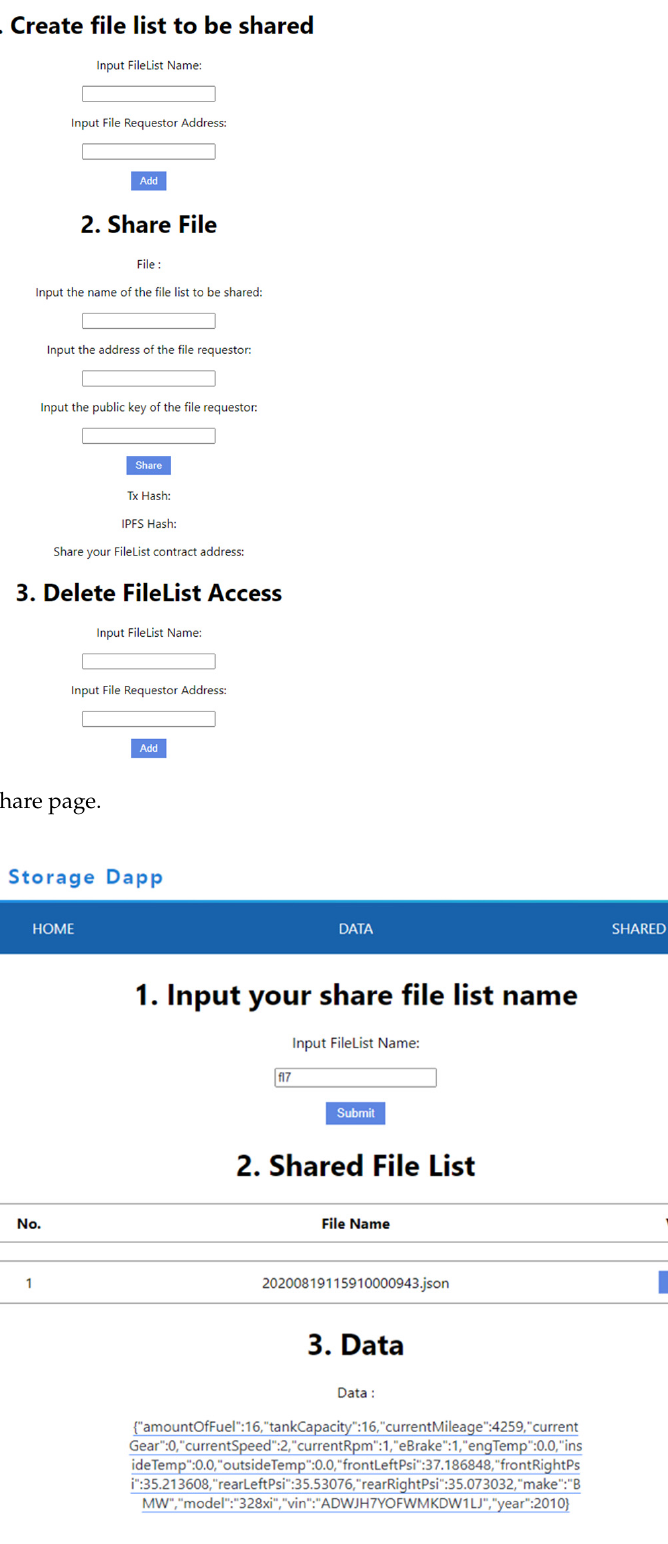
Figure 9. Share Data page.